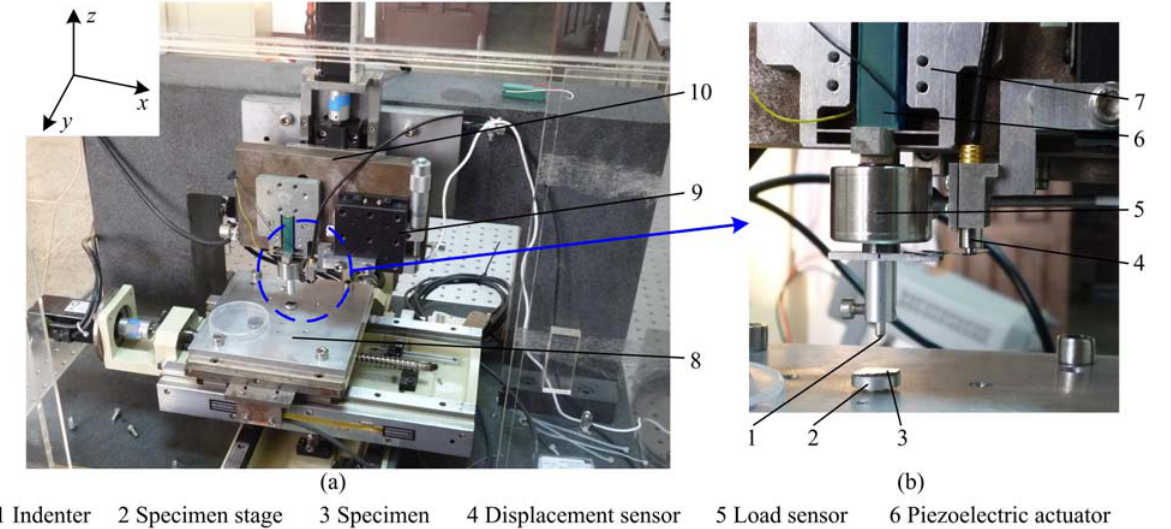
Figure 1. Photography of the self-made indentation